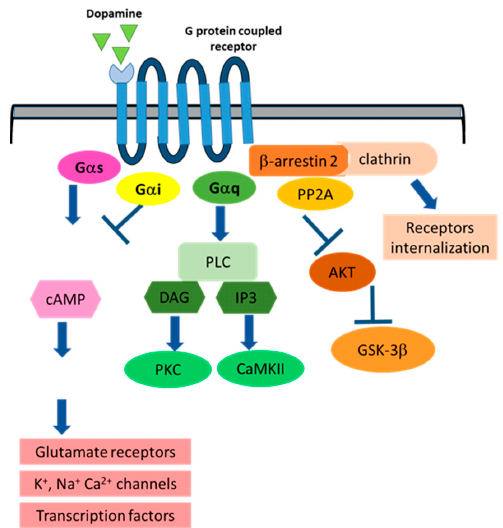
Figure 1 . The main signaling pathways modulated by DA upon binding to specific G protein- coupled receptors. coupled